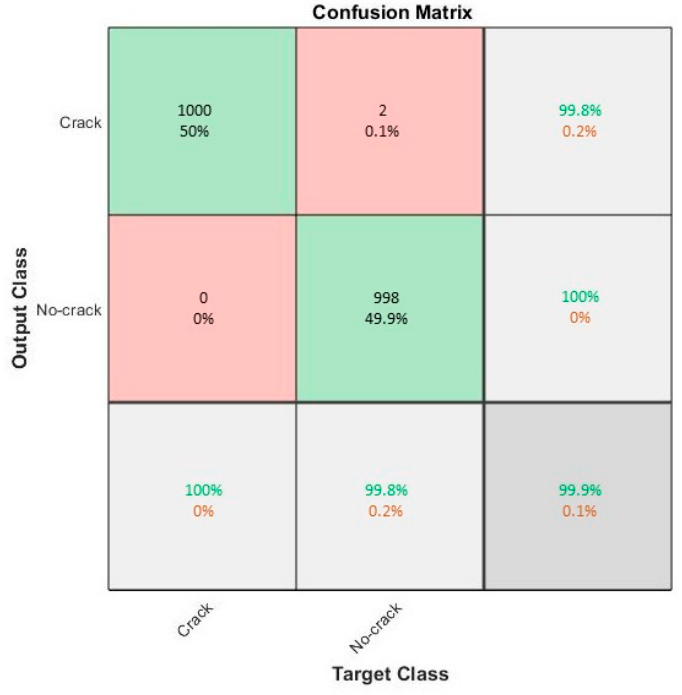
Figure 6. Confusion matrix of validation images.